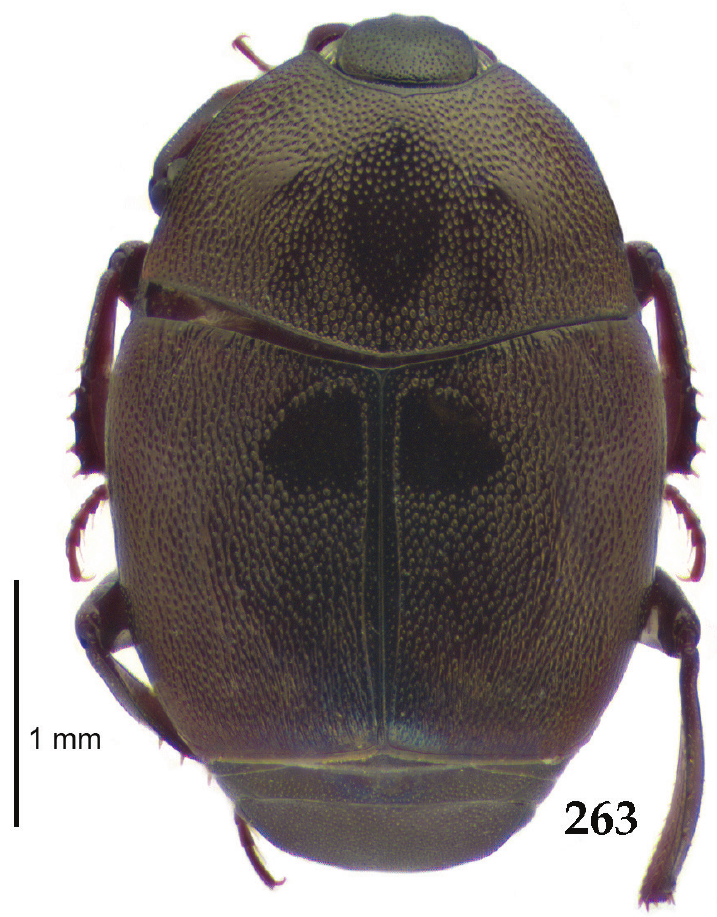
Figure 263. Saprinodes distinctus Dégallier, 1993, habitus, dorsal view.